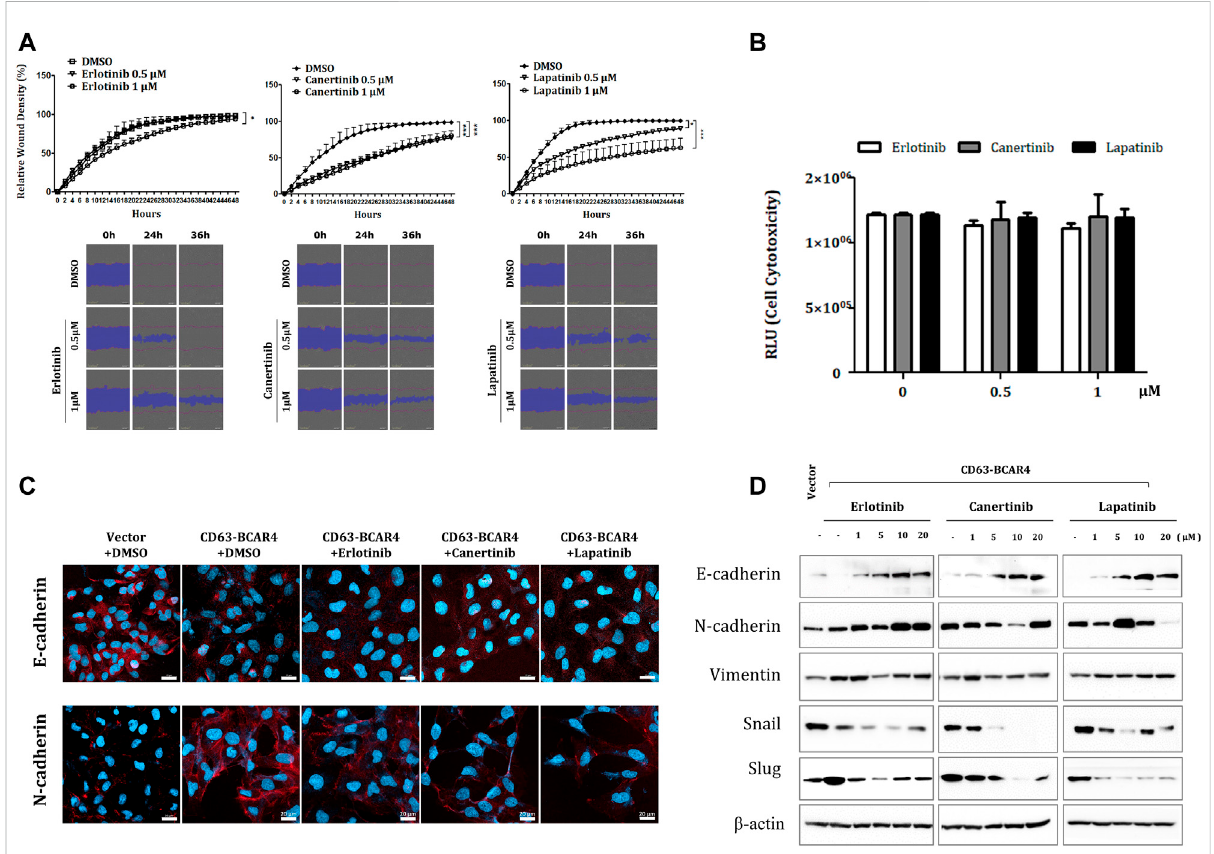
FIGURE 3 EffectsofindicateddrugsoncellmigrationandEMTsignaling. (A) Awoundhealingassaywasusedtocomparetheinhibitoryeffectsoferlotinib, lapatinib, and canertinib on cell migration of CD63-BCAR4 overexpressing BEAS-2B cells. The representative data and images from the replicated experimentsarepresentedandstatisticalsigni fi cancesaremarkedwith*( p < 0.05)and***( p < 0.0005). (B) Cytotoxicityofeachdrugwasassessedto con fi rmthatmotilityinhibitionwasnotduetocelldeath;RLU,relativelightunit (C) ImmunocytochemistryofE-cadherinandN-cadherinbefore and after drug treatment. (D) Protein levels of EMT-related molecules were evaluated using western blot